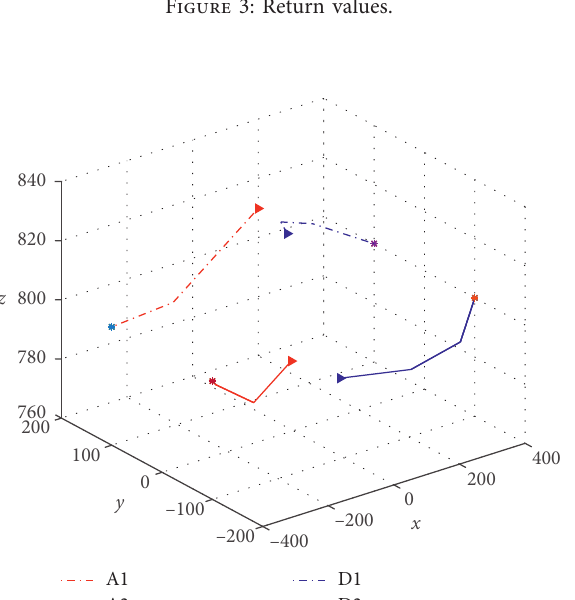
Figure 3: Return values.